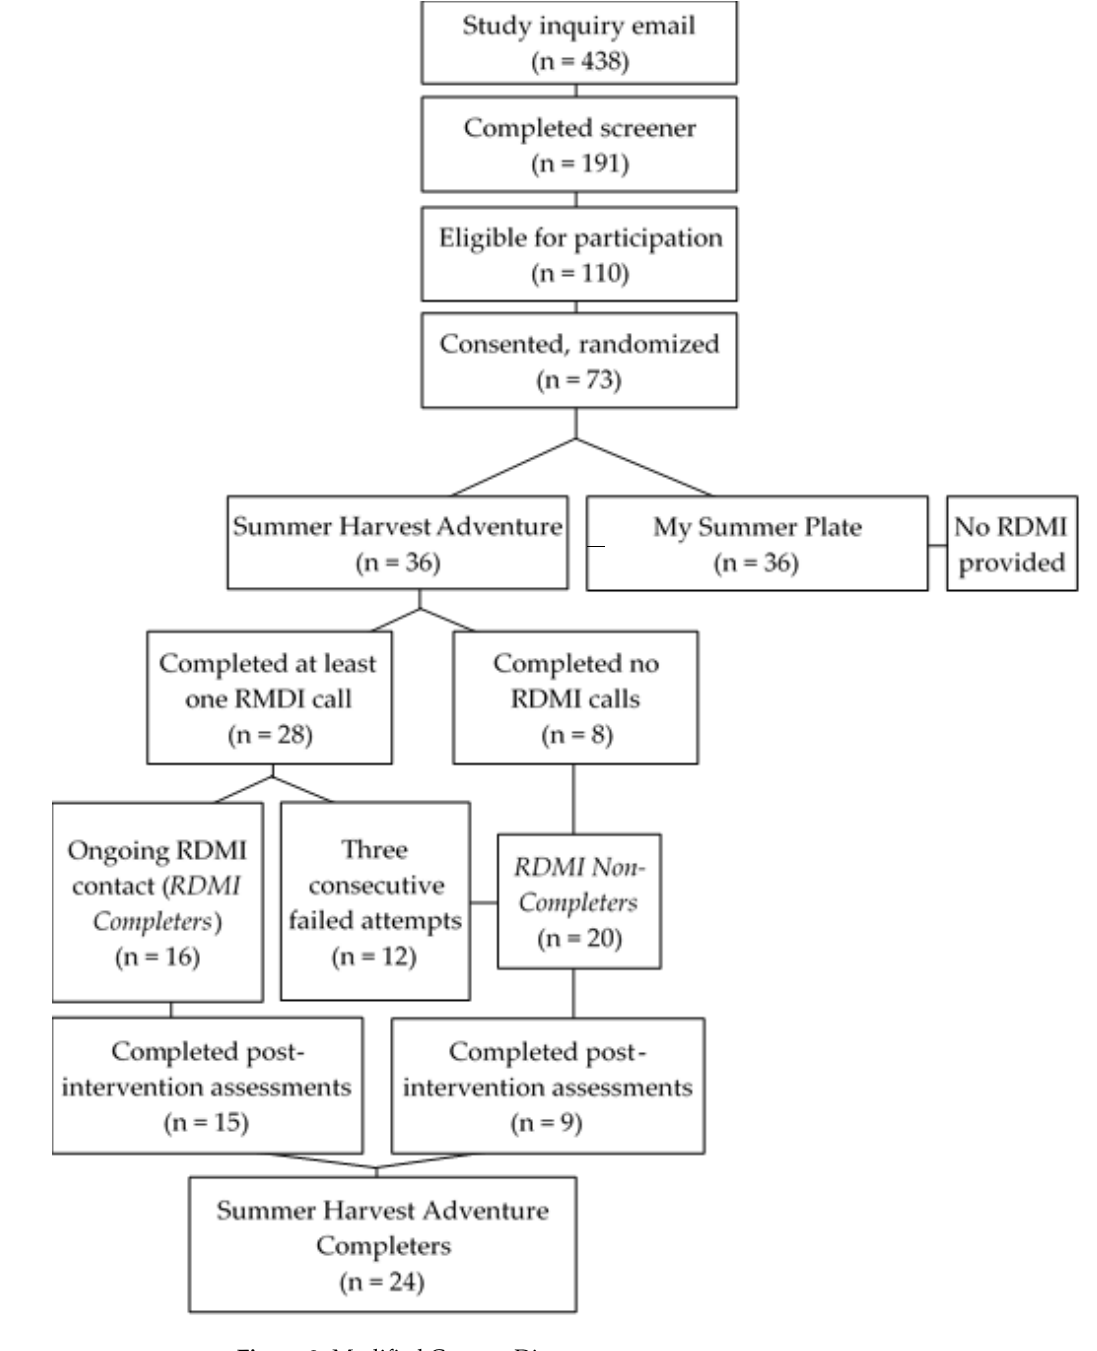
Figure 2. Modified Consort Diagram. Table 1. Demographic and Health Profiles of Parents and Adult Caregivers receiving Motivational Interviewing from a Registered Dietitian (RDMI).